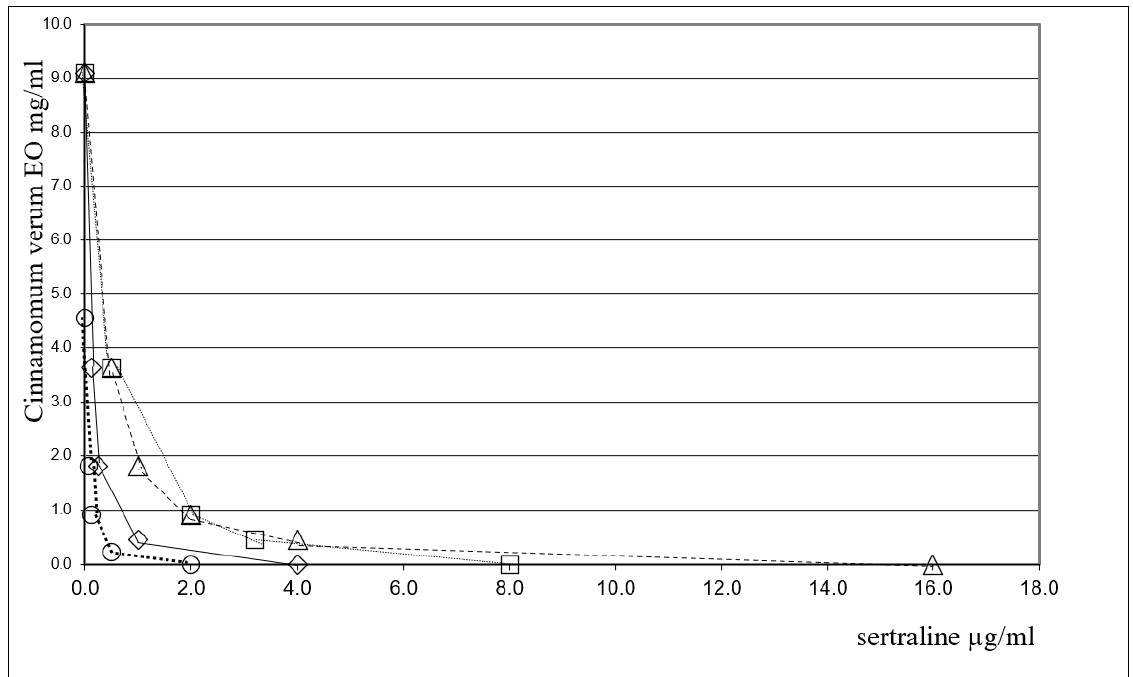
Figure 1. Isobole curves revealing the synergistic effect of sertraline with CEO in inhibiting four bacterial strains. P. aeruginosa ATCC 27853, E. faecalis ATCC 29212, K.pneuomoniae ATCC 13883, B.subtilis ATCC 6633.